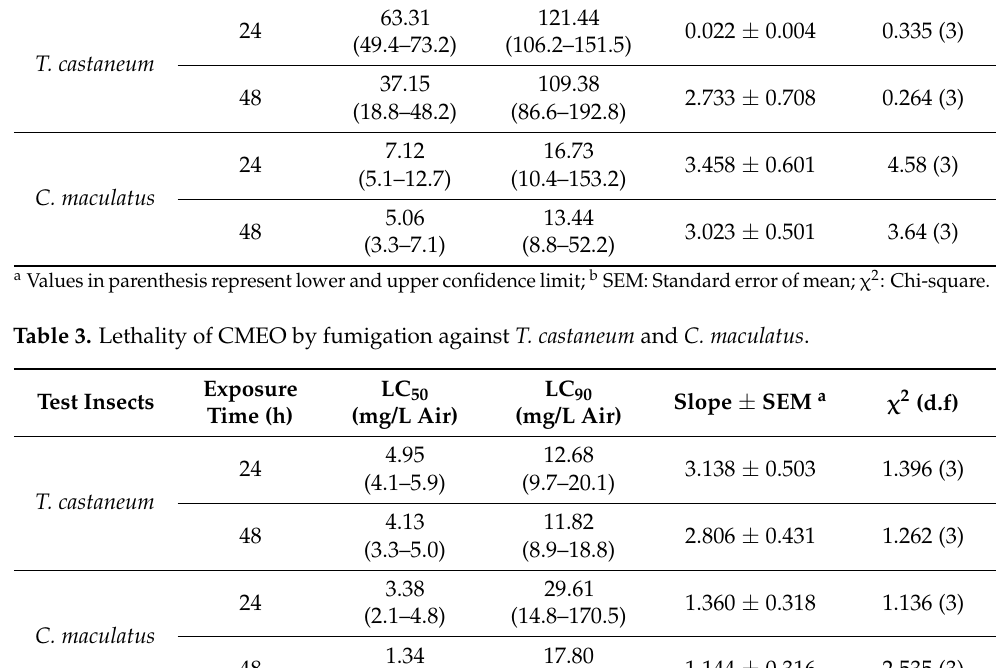
Table 2. Lethal concentrations on contact activity of CMEO against various insect pests. Test Insects